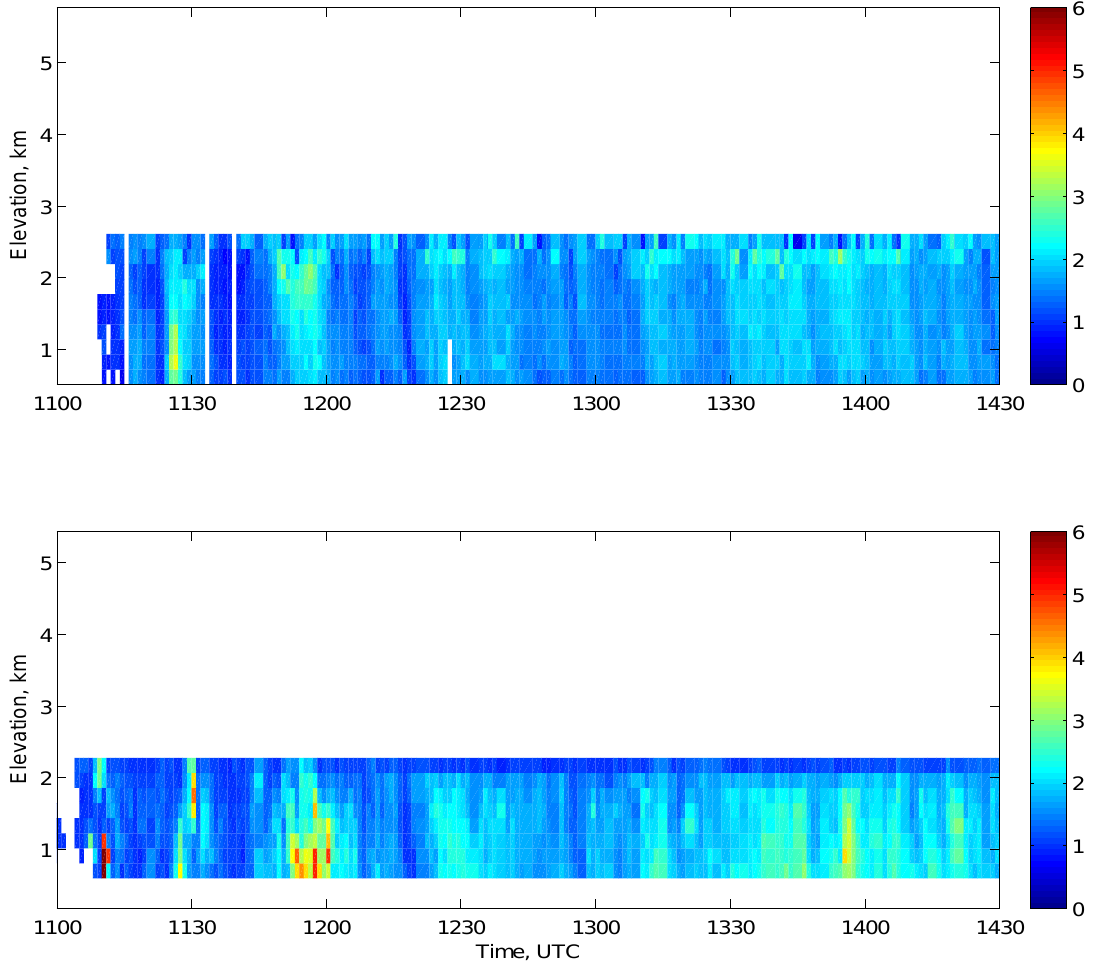
Fig. 4. RTI plots of D m for an exponential DSD retrieved from KOUN (upper panel) and the ARRC profiler (lower panel) during 11 March 2007 rain event. Units are in mm. Data above the melting layer not